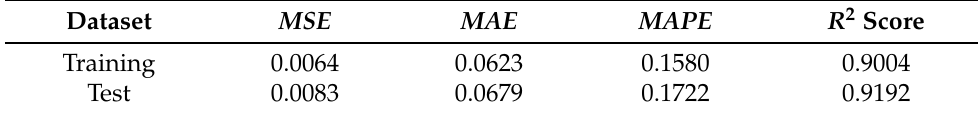
Table 3. Analysis of different metrics applied to the SVR-based multi-output regression tool.